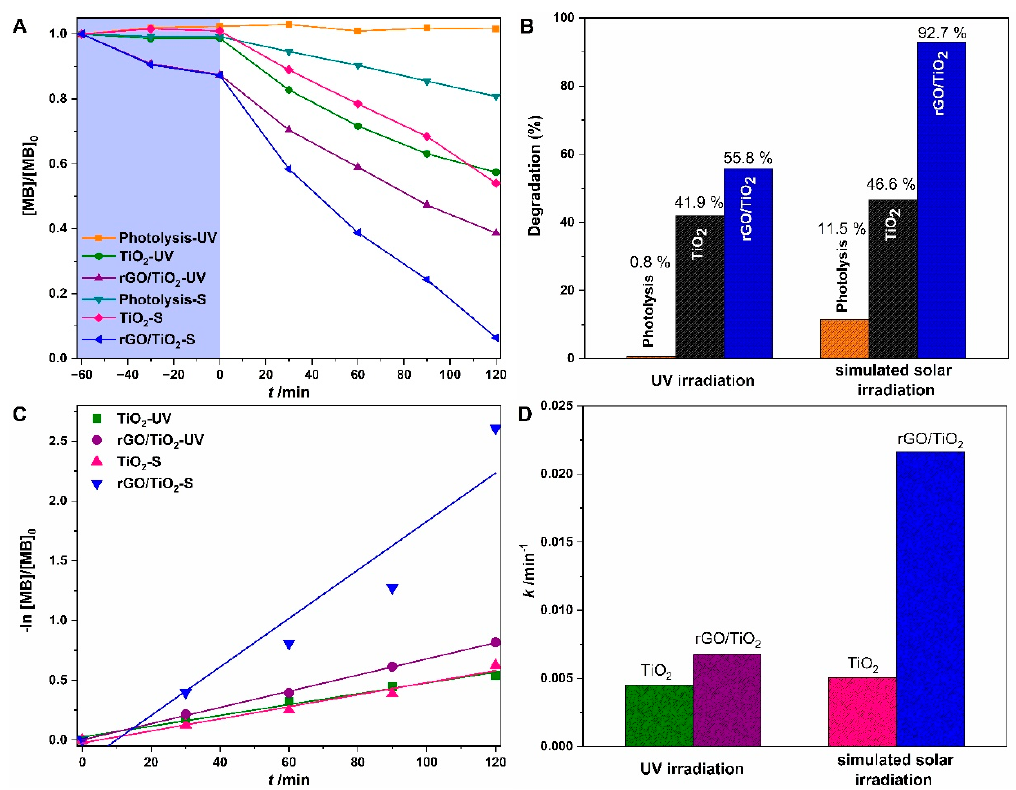
Figure 4. ( A ) Adsorption, photolytic and photocatalytic degradation of MB from an aqueous me- dium (milli-Q water) under ultraviolet-A (UV-A) and simulated solar irradiation (S) as a function of irradiation time. ( B ) photodegradation efficiency of photolytic and photocatalytic degradation of MB after 120 min. ( C ) the − ln [MB]/[MB] 0 versus reaction time, and ( D ) kinetic rate constants of photocatalytic reactions by immobilised rGO/TiO 2 nanocomposite photocatalyst.